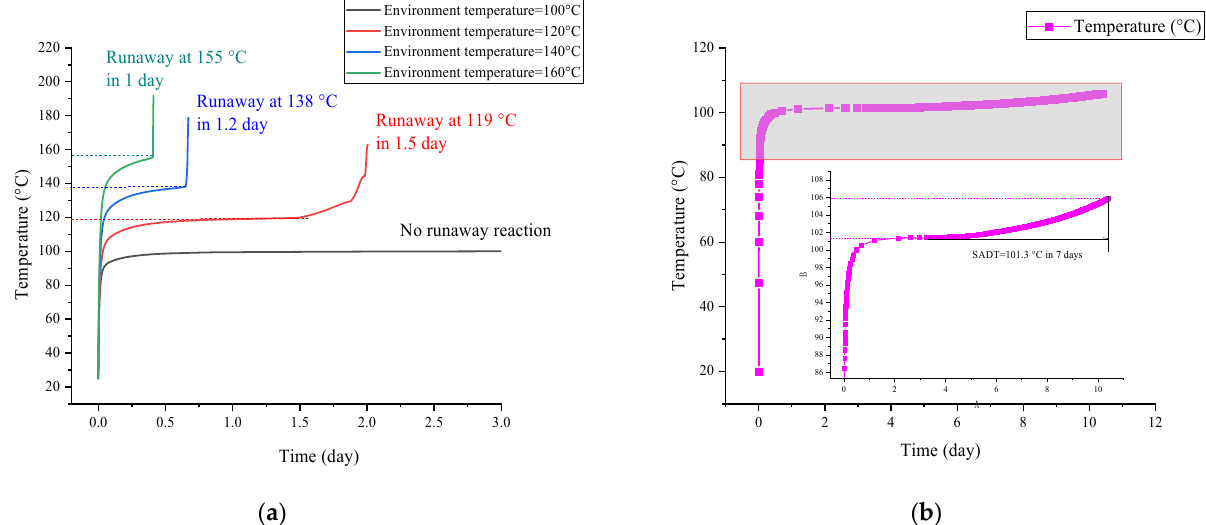
Figure 7. Simulation results of runaway reaction of the AIBA with a 20.0 kg box package at different ambient temperatures ( a ) and SADT ( b ).